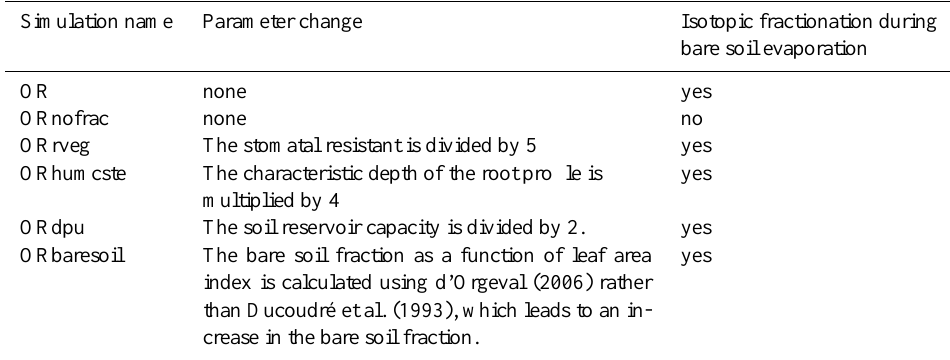
Table 1. List of sensitivity tests using the LMDZ-ORCHIDEE model.